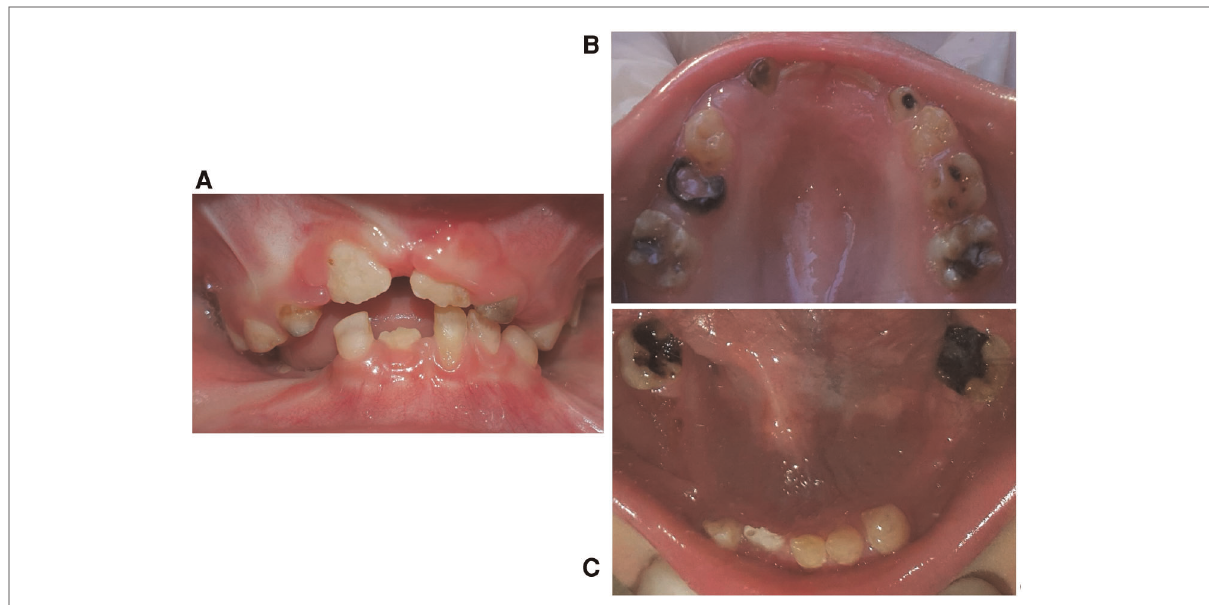
FIGURE 2 Intraoral photographs. ( A ) Frontal view in occlusion, ( B ) maxillary arch, ( C ) mandibular arch.